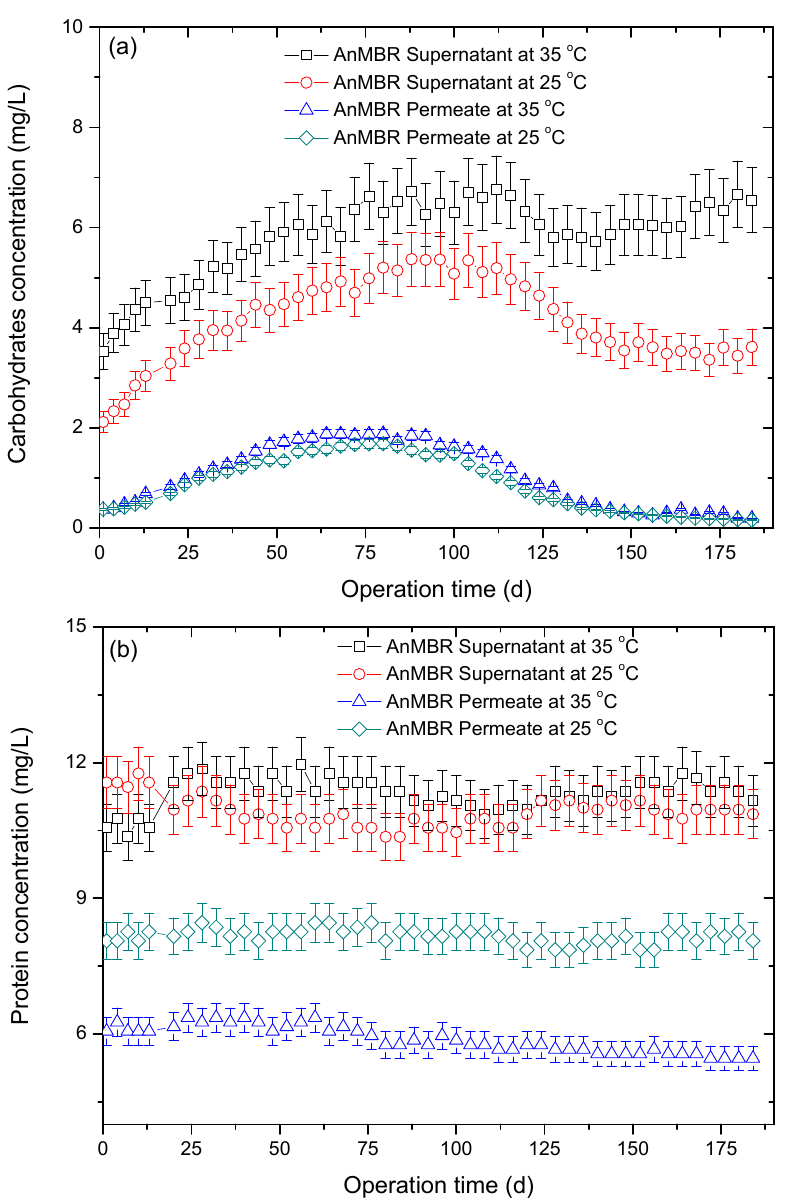
Figure 2. The changes in carbohydrate ( a ) and protein ( b ) contents in soluble microbial products (SMP) during the operation time.